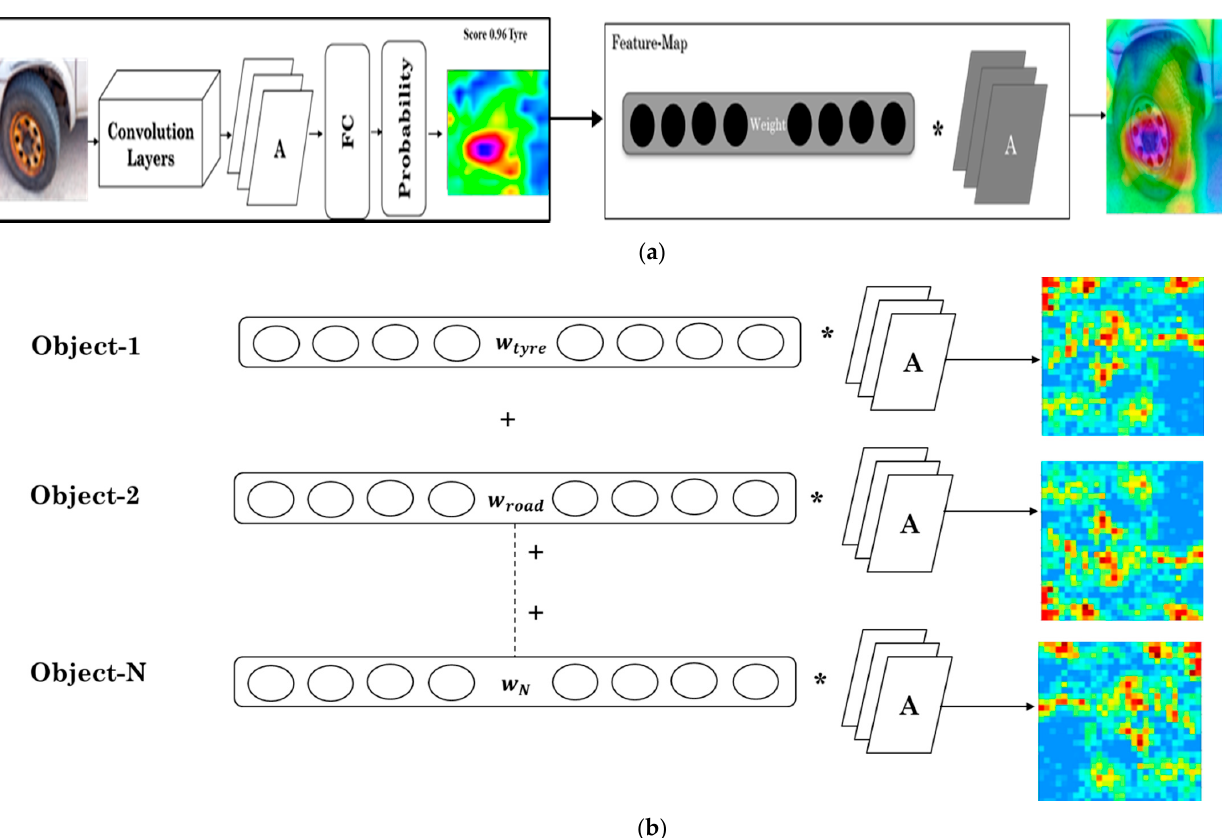
Figure 3. ( a ) Exploit feature-map basic idea and ( b ) exploit map into objects. * Activation map. In order to define an explanatory rule for a black box f(x) , one must start by specifying which variations of the input x will be used to study f . The aim of saliency is to identify which regions of an image x 0 are used by the black box to produce the output value f(x 0 ) . We can do so by observing how the value of f(x) changes as x is obtained “deleting” dif- ferent regions R of x 0 . For example, if f ( x 0 ) = +1 denotes a robin image, we expect that f(x) = +1 as well unless the choice of R deletes the robin from the image. Given that x is a perturbation of x 0 , this is a local explanation, and we expect the explanation to characterize the relationship between f and x 0